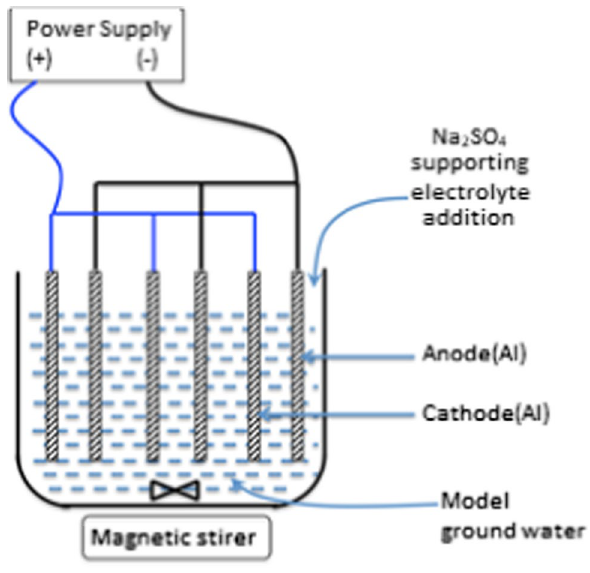
Fig. 1 Experimental setup used in the electrocoagulation (EC) treat- ment